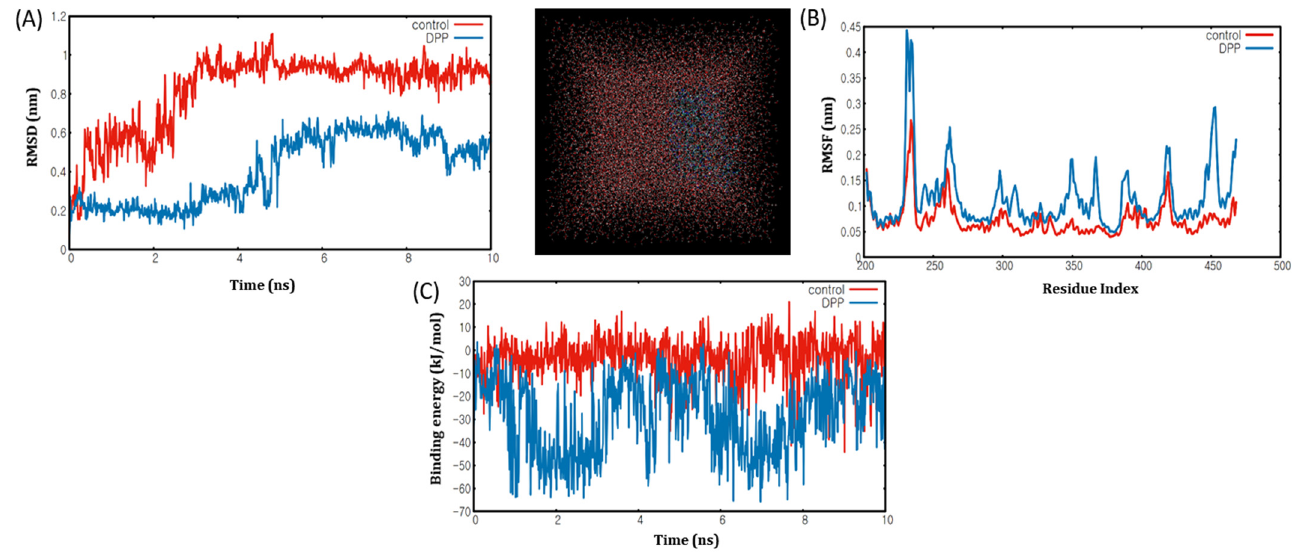
Figure 6. MD simulation analyses ( A ) root mean square deviation (RMSD) plot of PPAR α -Eicosapentaenoic acid (control) and 1,3-Diphenyl-2-propanone (dpp) complex at10 ns of molecular dynamic simulation. ( B ) the RMSF plot of the back-bone heavy atoms of the Eicosapentaenoic acid (Red) and 1,3-Diphenyl-2-propanone (Blue) complex. ( C ) binding energy plot of Eicosapentaenoic acid (Red) and 1,3-Diphenyl-2-propanone (Blue) complex at10 ns.